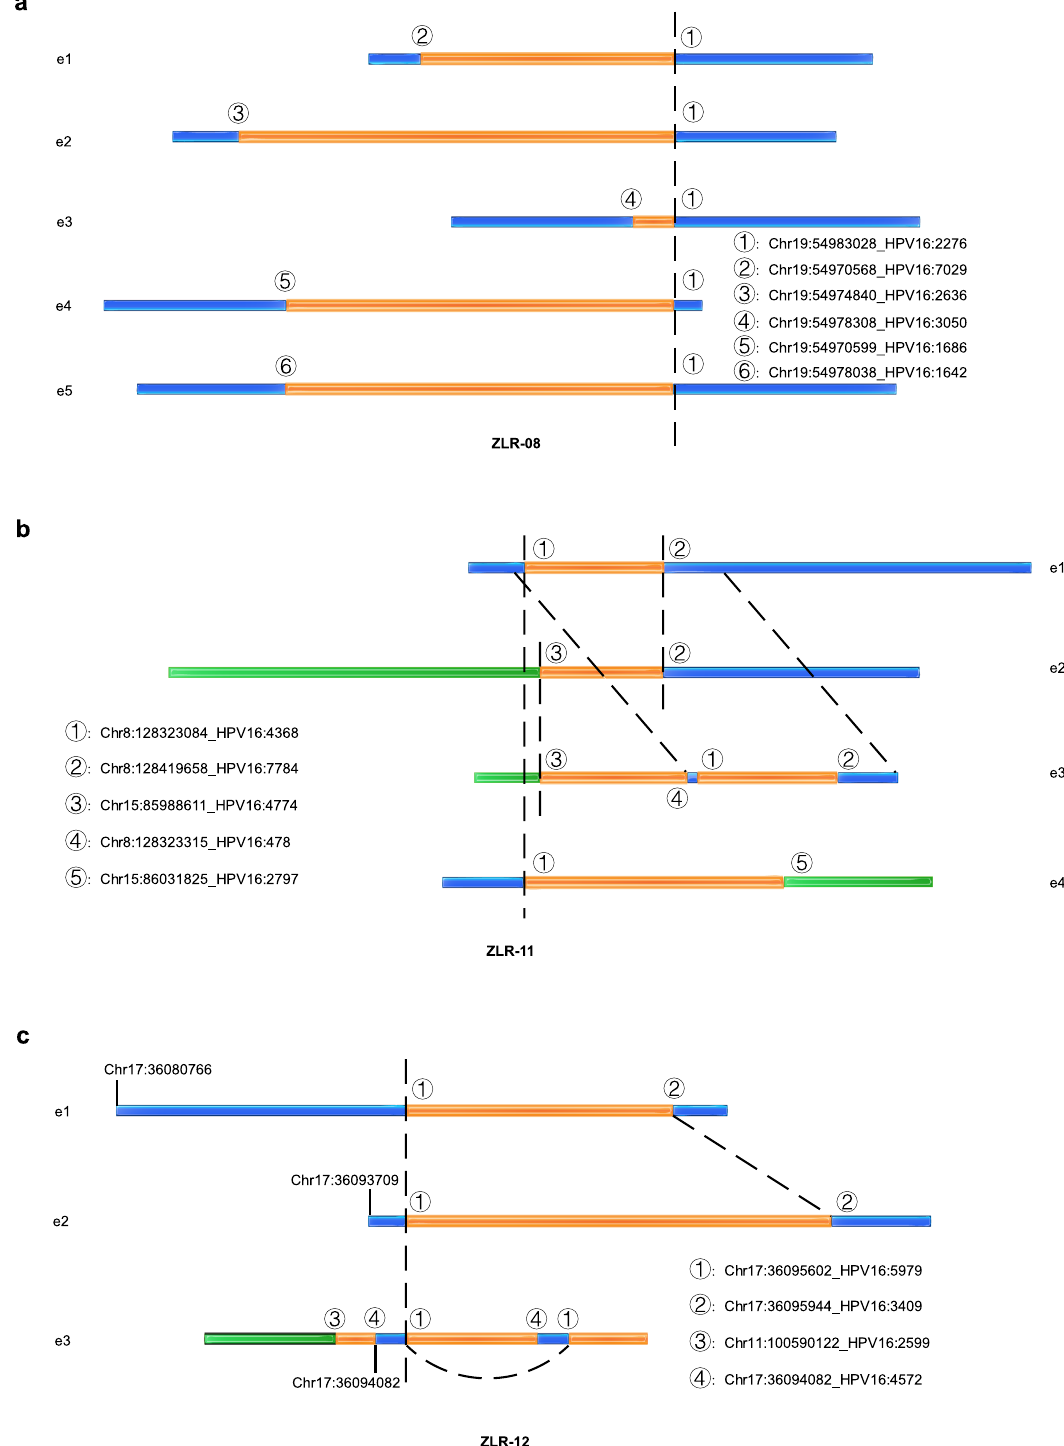
Fig. 4 Breakpoints shared in clonal integration events and HPV integration-related inter-chromosomal translocations. a – c Schematic illustrations of authentic chimeric reads representing clonal integration events that participated in the use of shared breakpoints: a ZLR-08, b ZLR-11, and c ZLR-12. The orange box represents the virus genome; the blue and green boxes represent different chromosomes of the human genome. Identical breakpoints were designated by the same number and were linked by dashed lines. Clonal integration events in ZLR-11 and ZLR-12 induced translocations between chromosomes. Source data are provided as a Source Data fi